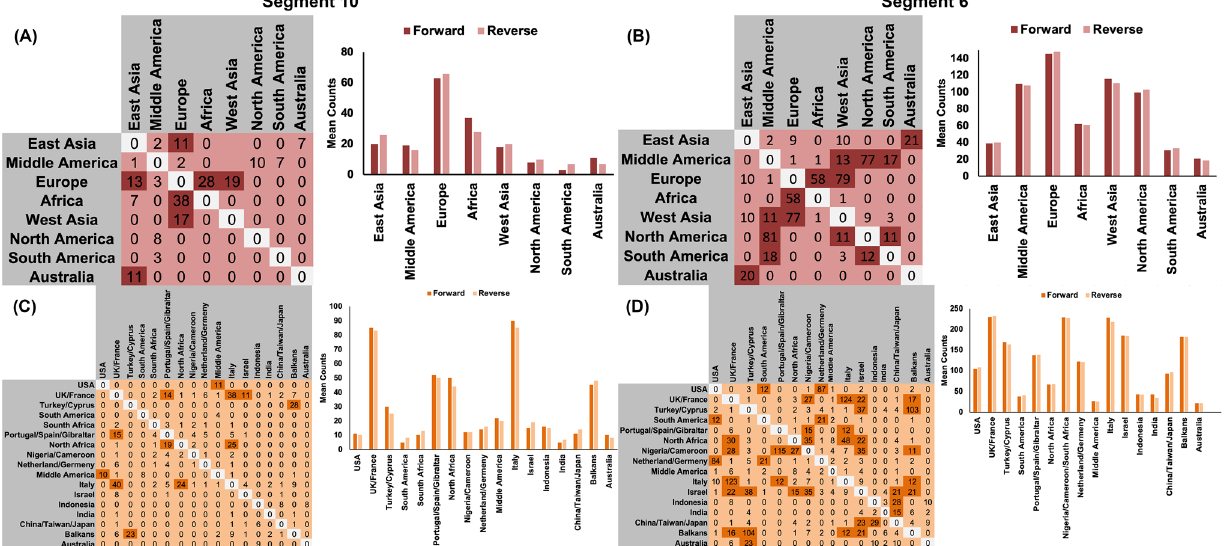
Figure 4. Global posterior mean counts of the Markov jumps (MJ) over the phylogeny of bluetongue virus. Matrix on the top summarize relative forward (columns) and reverse (rows) transitions between pairs of discrete traits (i.e., countries). Cells shaded dark orange indicate MJs greater than ten. Charts on the bottom summarize total relative forward and reverse transitions for each country. ( A , B ) MJ estimates inferred from continental level phylogeographic analysis ( C , D ) MJ estimates inferred from country level phylogeographic analysis. ( A , C ) Indicate segment 10. ( B , D ) Indicate segment